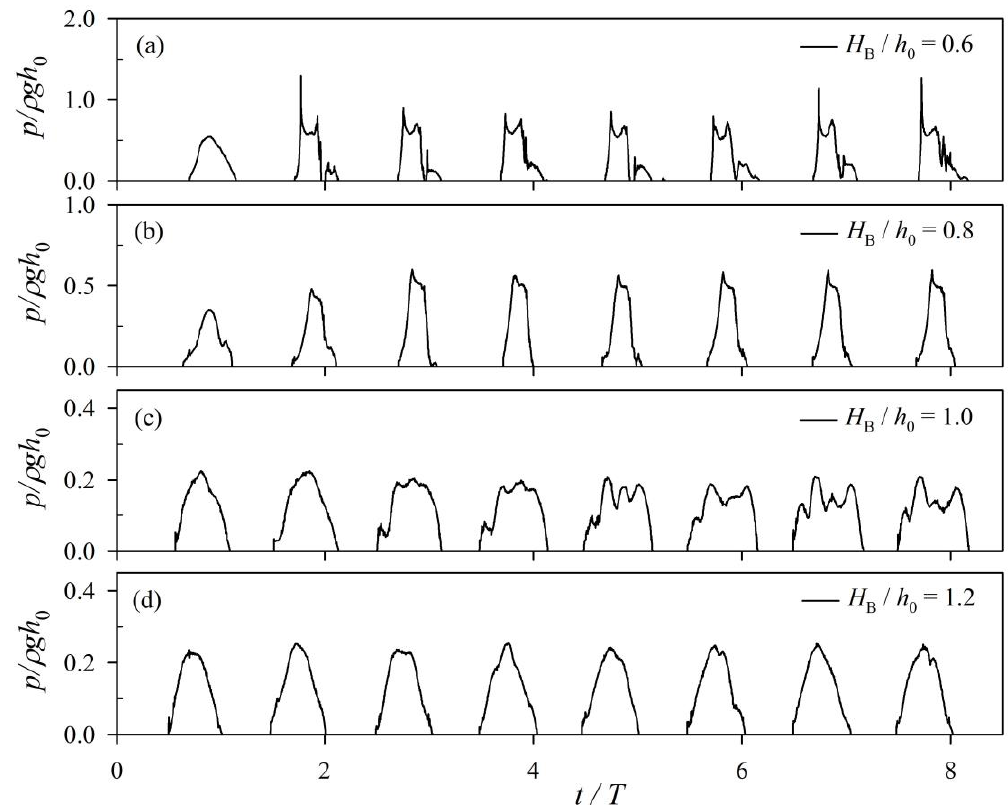
Figure 7. Time histories of impact pressure at point A with different baffle heights ( T = 1.91 s, ω / ω 0 = 1.004). ( a ) H B / h 0 = 0.6; ( b ) H B / h 0 = 0.8; ( c ) H B / h 0 = 1.0; ( d ) H B / h 0 = 1.2.